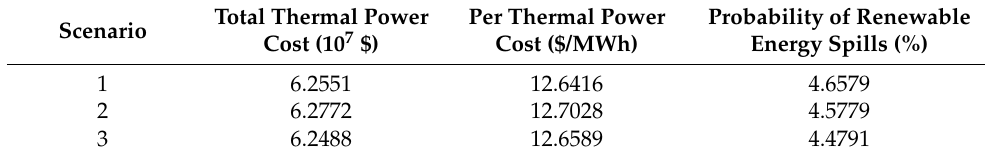
Table 4. Operation